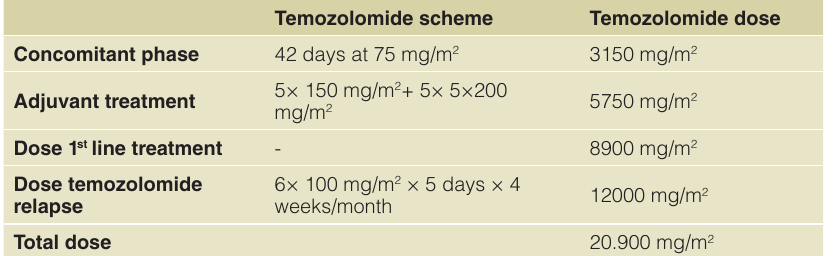
Table 1. Total temozolomide dose before the